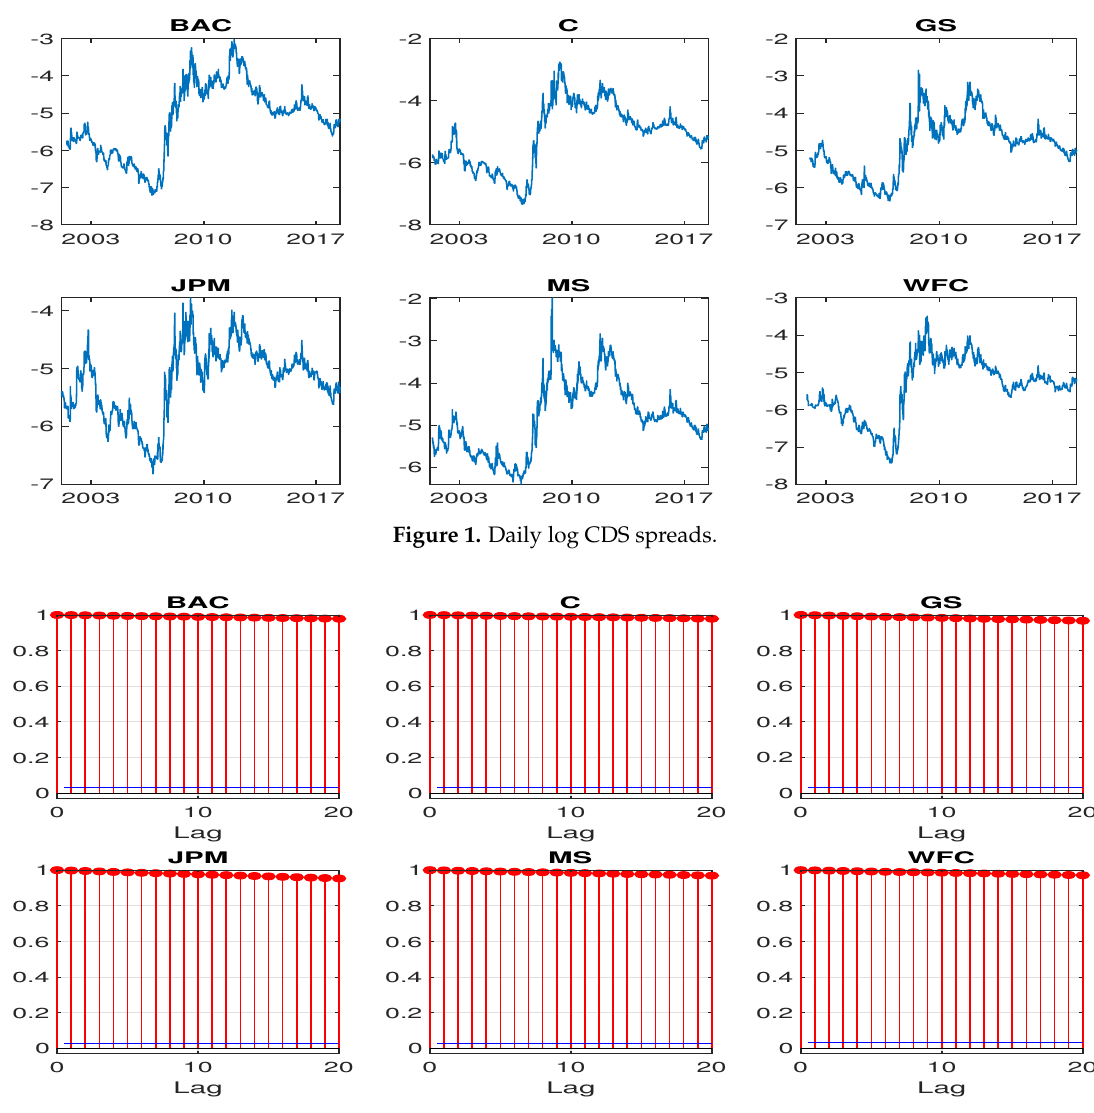
Figure 2. First 20 sample autocorrelations for daily log CDS spreads.